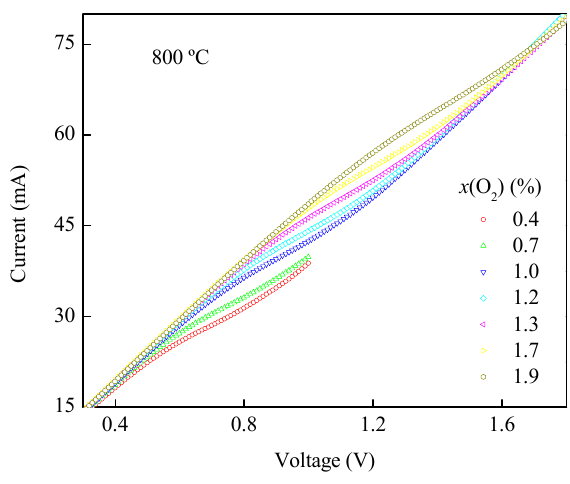
Figure 7. I - V characteristic curves in different x (O 2 ).